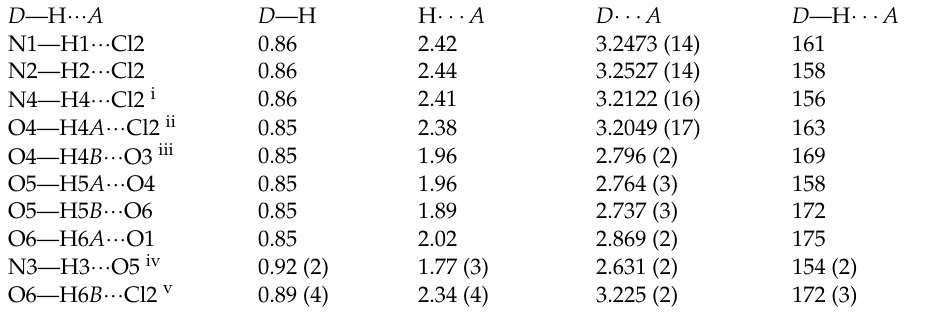
Figure 4. Part of the crystal packing of (I) view along ( a ) [101], ( b ) [10–1] and ( c ) [001] direction, hydrogen bonds are shown as green and yellow dashed lines, H atoms not involved in hydrogen bond have been omitted for clarity. ( d ) 3,3,3,4,5-connected pentanodal topological net representing the hydrogen bond chain structure of (I). Table 2. Hydrogen-bond geometry (Å, º) for